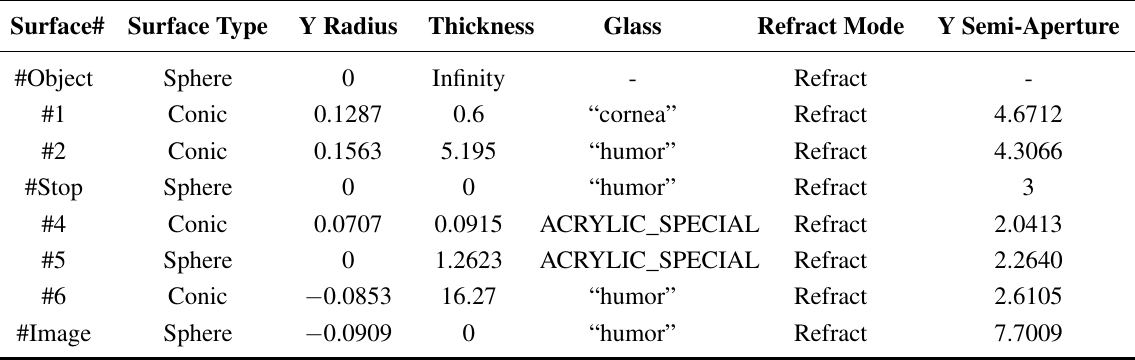
Table 5. The lens parameter after proposed genetic algorithm (GA) optimization for pupil size 5 mm.